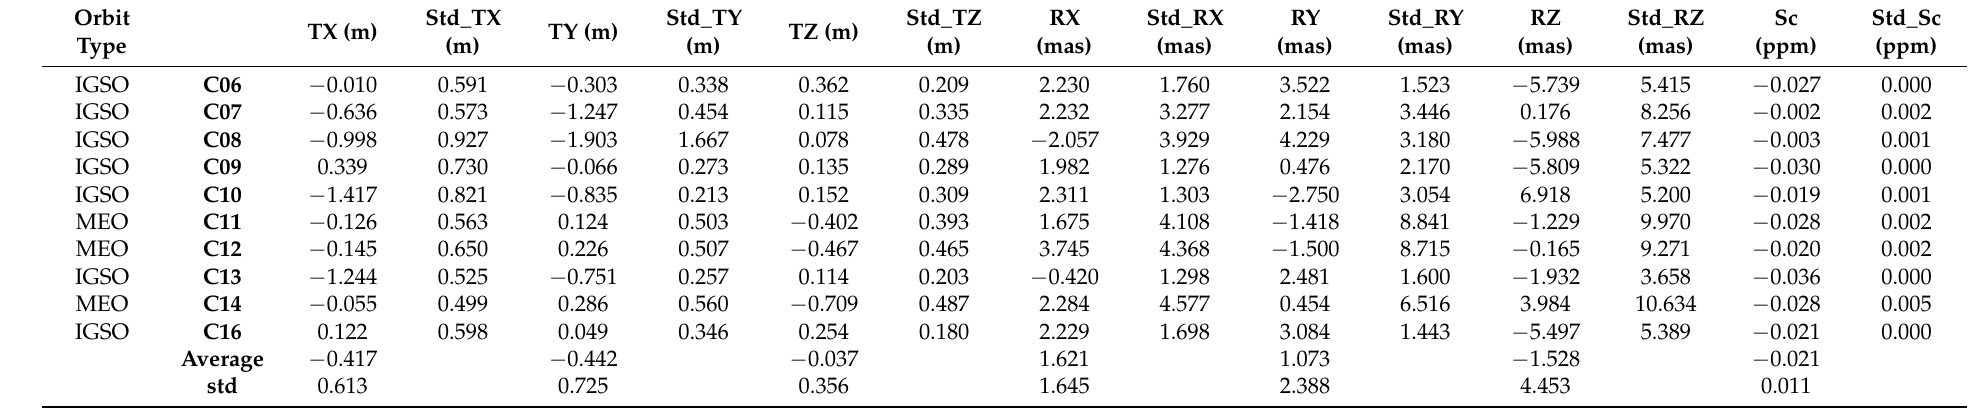
Table A4. Helmert parameters relating the Beidou reference frame to the ITRF2014 reference frame of the precise ephemeris of CODE. Average values for January 2020.